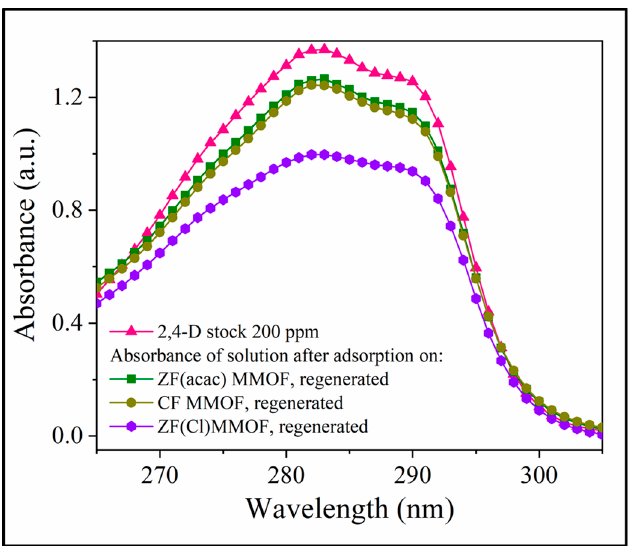
Figure 10. UV-Vis spectra after 24 h of adsorption period for all three washed and dried MMOFs, in comparison with the 2,4-D starting solution curve.